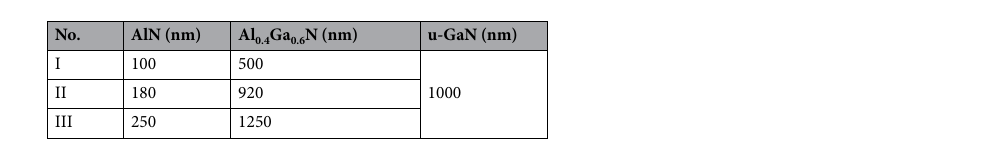
Table 1. Characteristics of the thickness of MOCVD buffer layers used in this